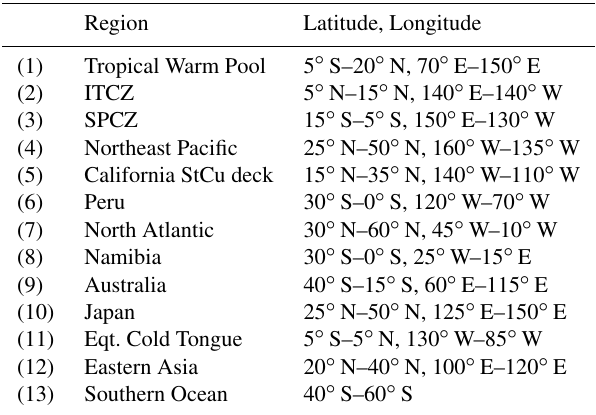
Table 1. Definition of the 13 regions used in the CFODD regional analysis, corresponding to the boxes in Fig.